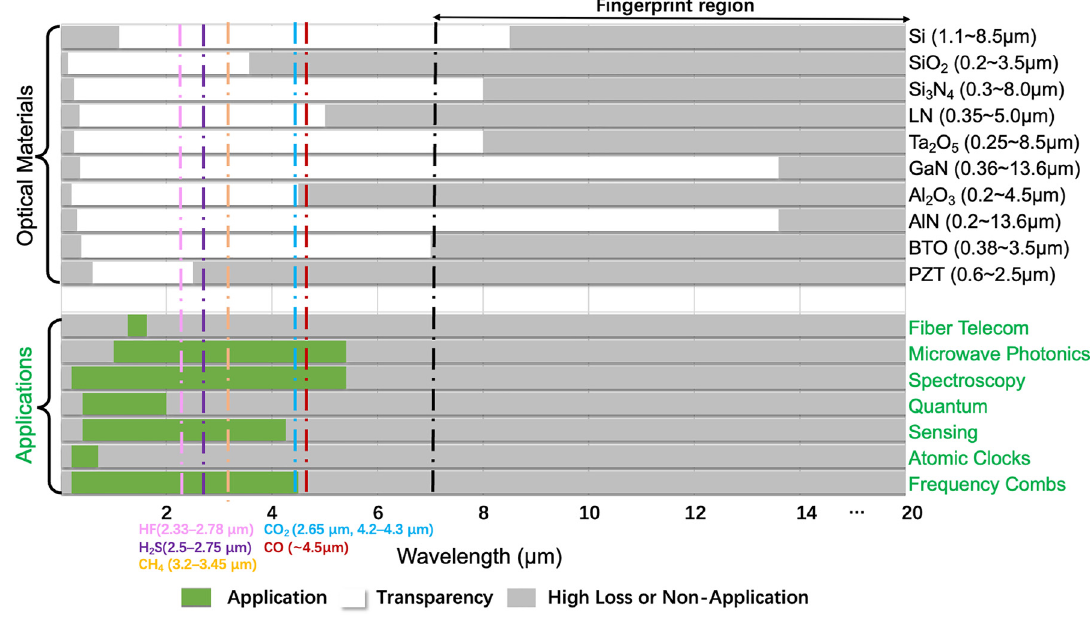
Figure 1: Transparency windows of different photonic materials and applications over various spectral windows.